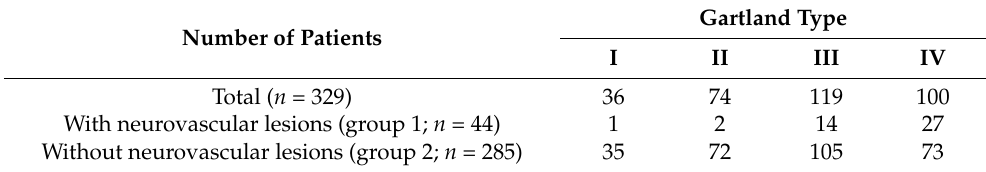
Table 3. Numbers of patients with and without neurovascular lesions per Gartland